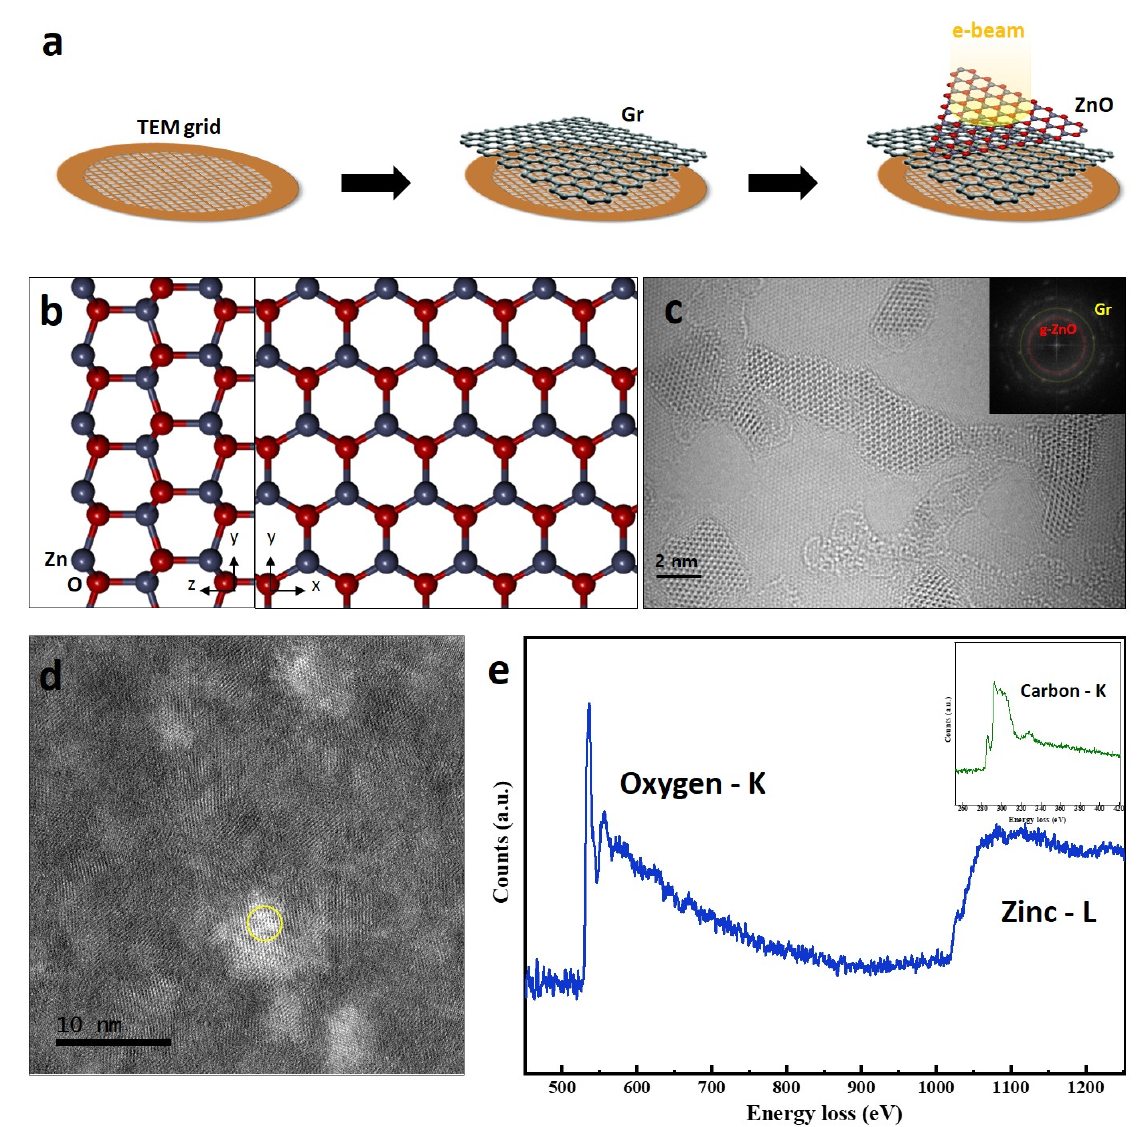
Figure 1. Graphene-like ZnO (g-ZnO) nanosheets on a monolayer graphene sheet. ( a ) Schematic showing a sample preparation for ACTEM imaging. ( b ) Atomic model showing top and side views of a wurtzite ZnO structure. ( c ) ACTEM image showing g-ZnO nanosheets on the monolayer graphene sheet with a FFT of the graphene and the ZnO sheets. ( d ) STEM HAADF image of the ZnO on the graphene. ( e ) EEL spectrum obtained from the yellow circle in ( a ) showing oxygen K-edge and zinc L-edge of the g-ZnO sheet on the graphene. The inset shows the carbon K-edge from the graphene.